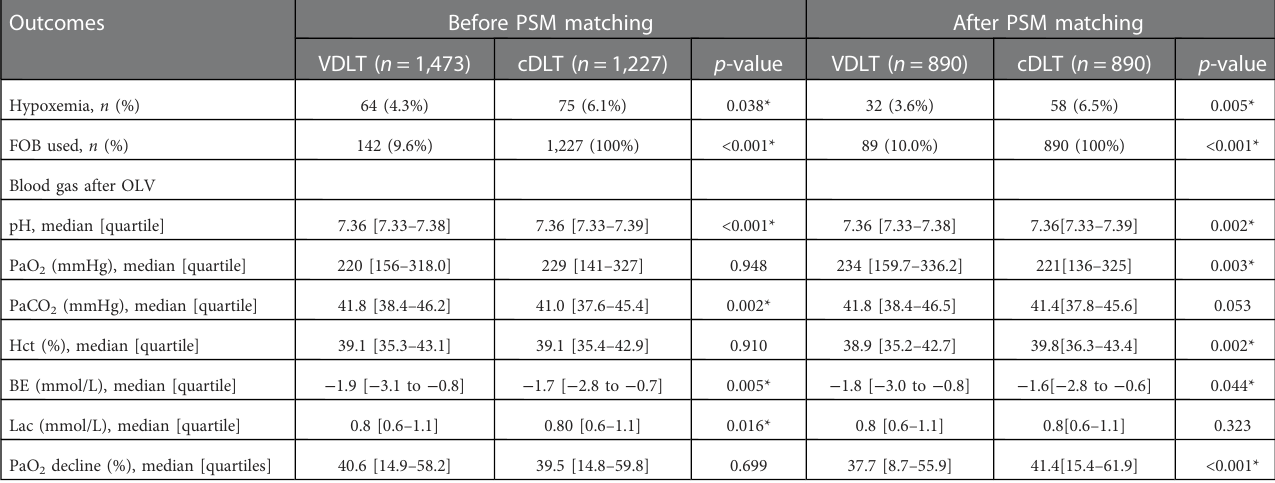
TABLE 2 VDLT vs. cDLT: outcomes (before and after PSM matching). Outcomes